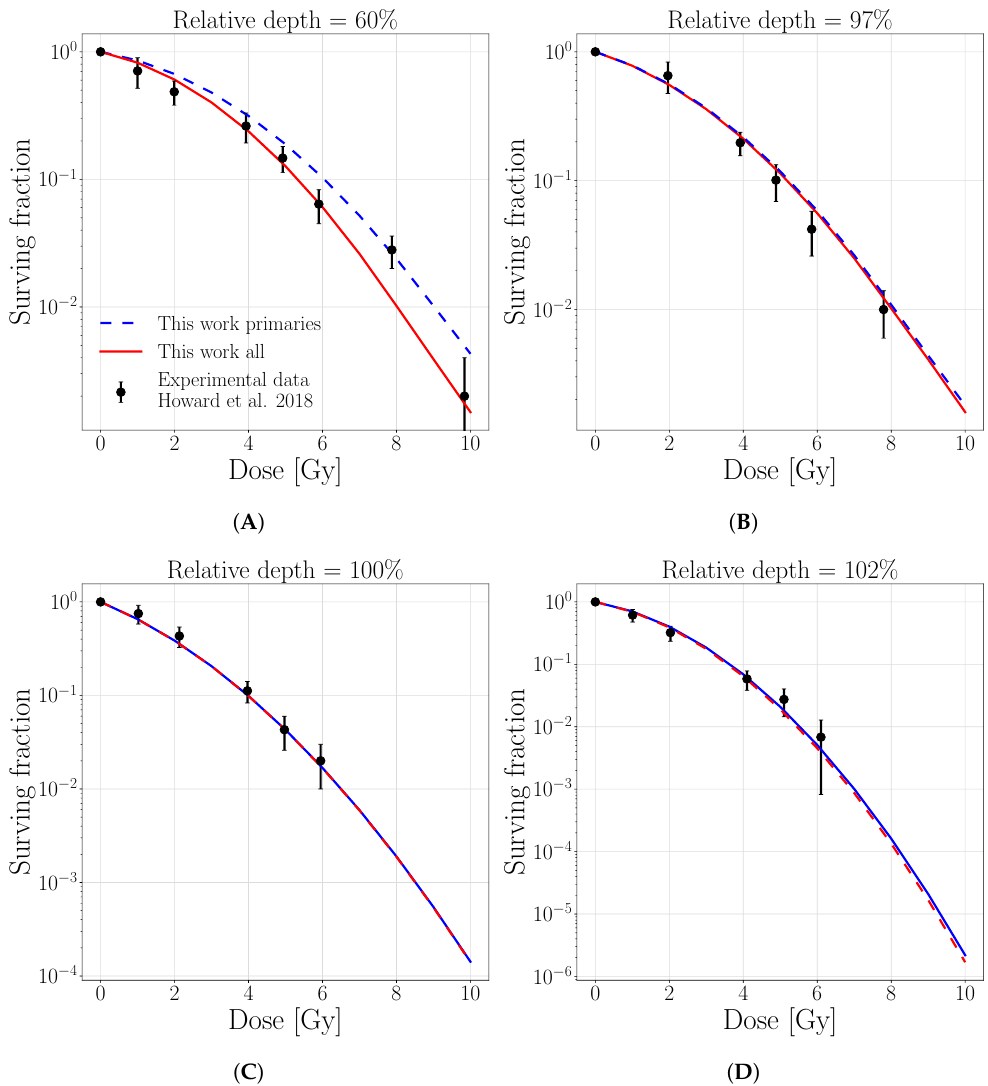
Figure 7. Surviving fraction for T98 cell line as a function of dose for an initial proton beam energy of 71 MeV at the depths of ( A ) 10.1 (60%), ( B ) 16.7 (97%), ( C ) 17.2 (100%), ( D ) 17.5 (102%). Solid lines represent linear interpolations for the surviving fraction evaluated with 1 MeV step, considering the contribution of only primary protons (dashed blue) or all particles (solid red). The legend stands for all